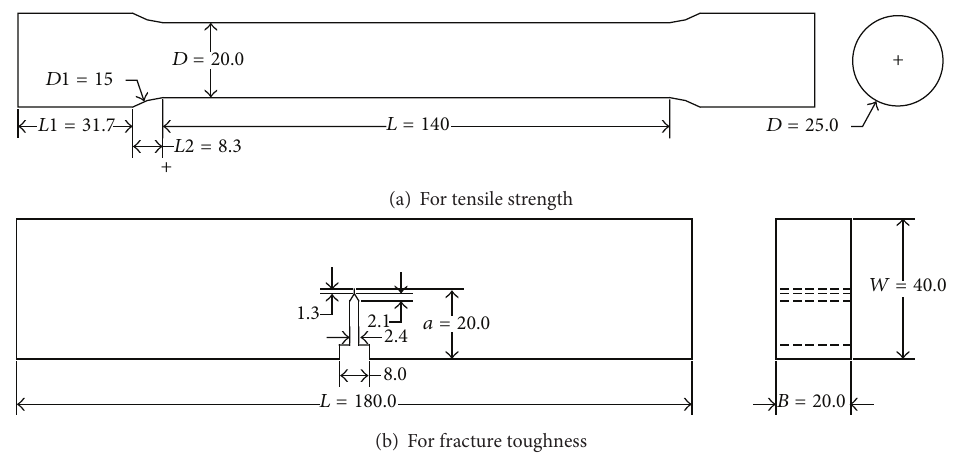
Figure 1: Test specimen (unit: mm).